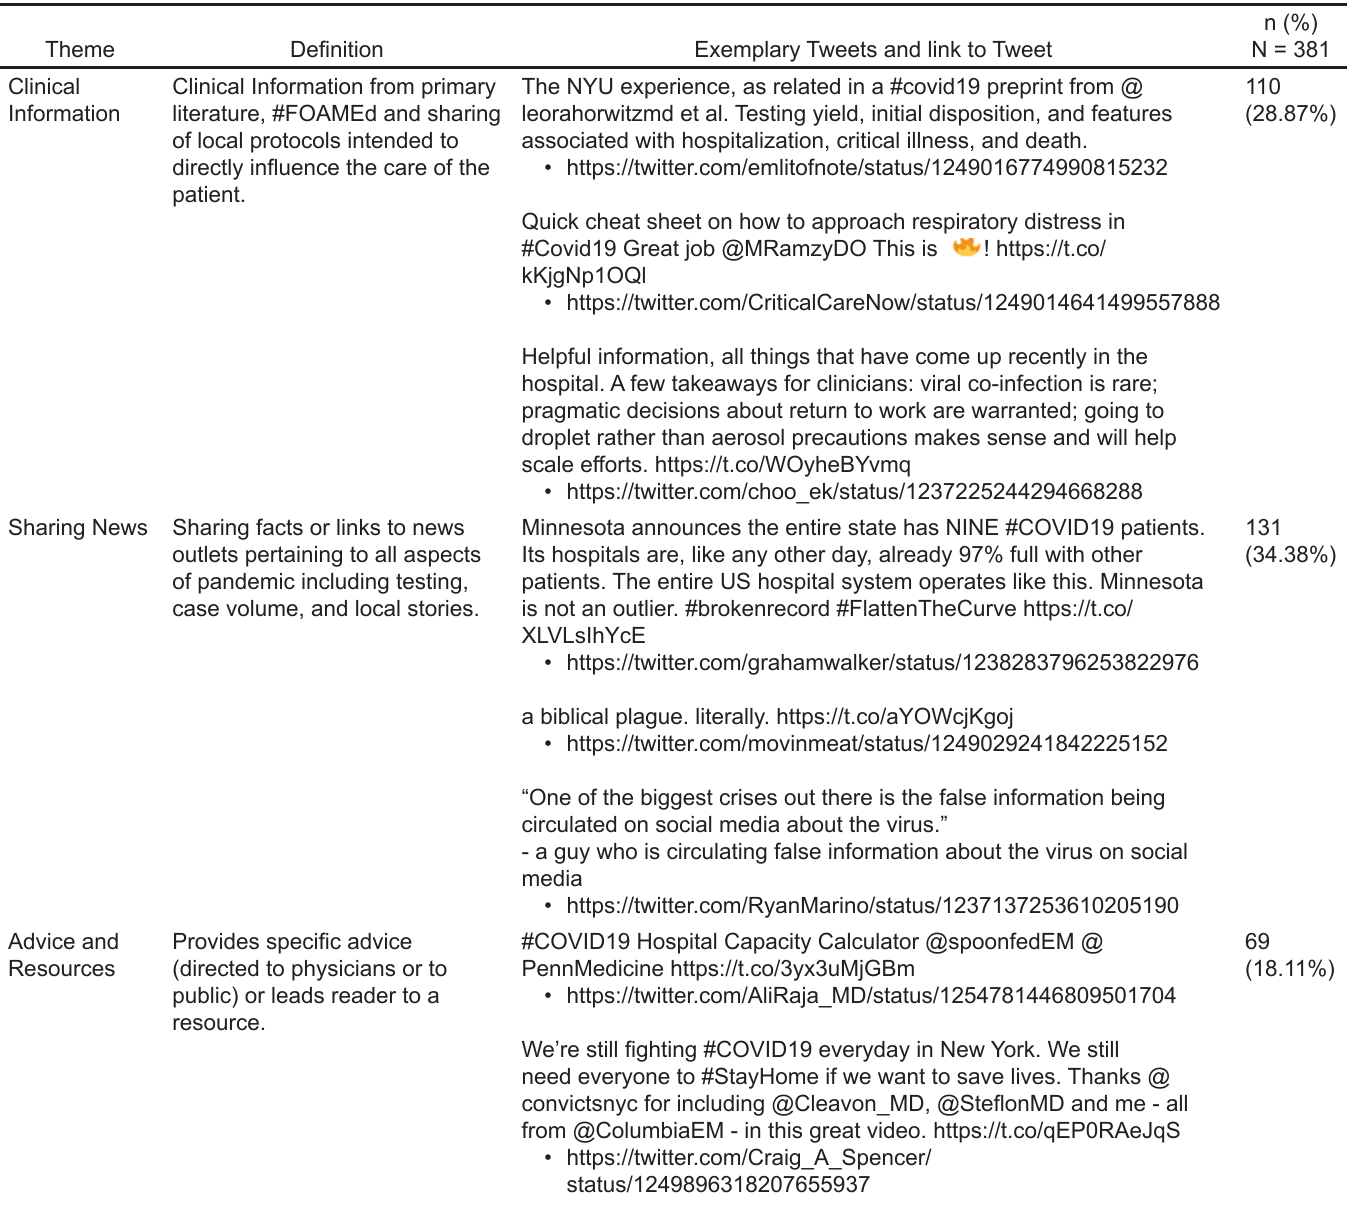
Table 4. Themes within Twitter